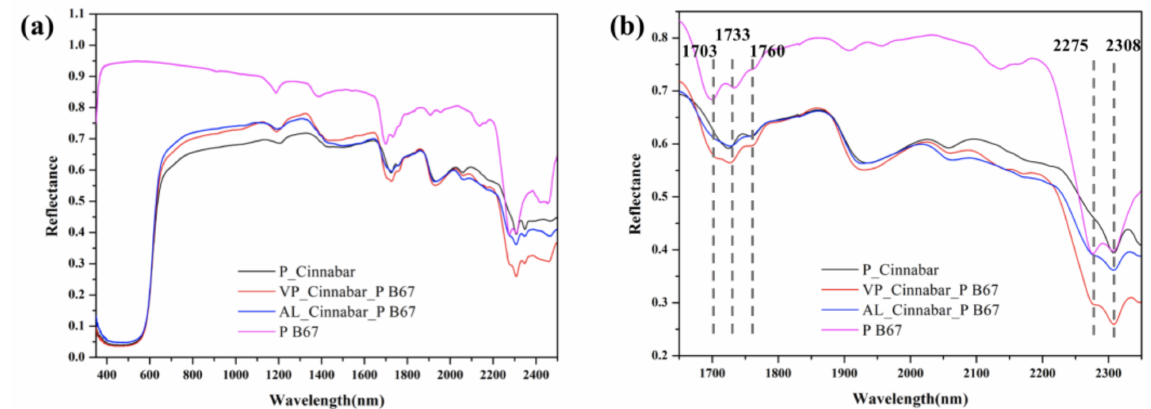
Figure 9. The full range reflectance spectrum ( a ) and the selected region reflectance spectrum ( b ) of pure P B67, cinnabar tempera mock-up (P), cinnabar tempera varnished with P B67 (VP) and mock-up after laser cleaning (AL). All spectra reported were collected in Section 8 of painting mock-ups (Figure